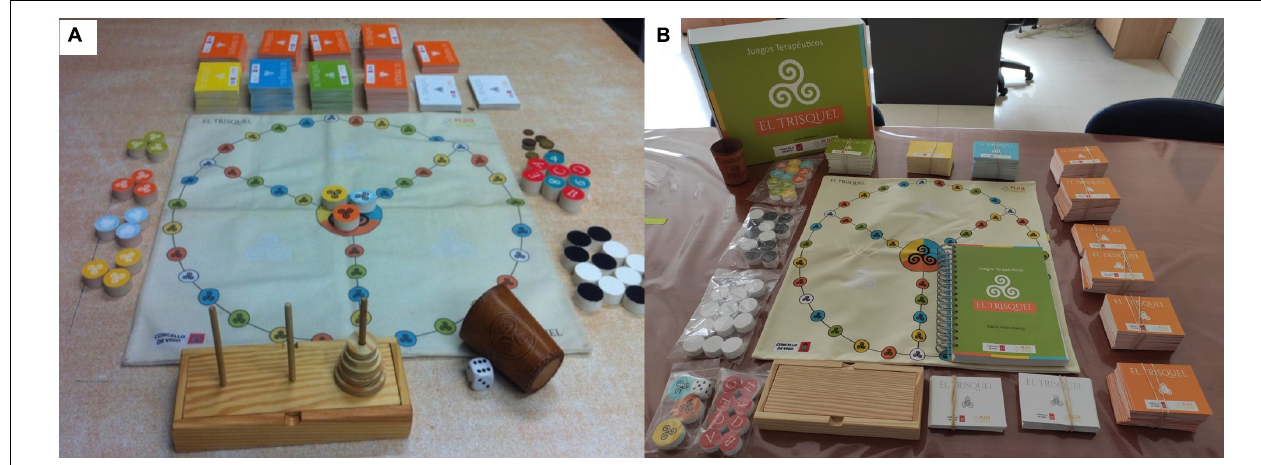
FIGURE 1 | (A) Trisquel 2014 version, (B) box, professional’s manual and elements of the Trisquel 2014